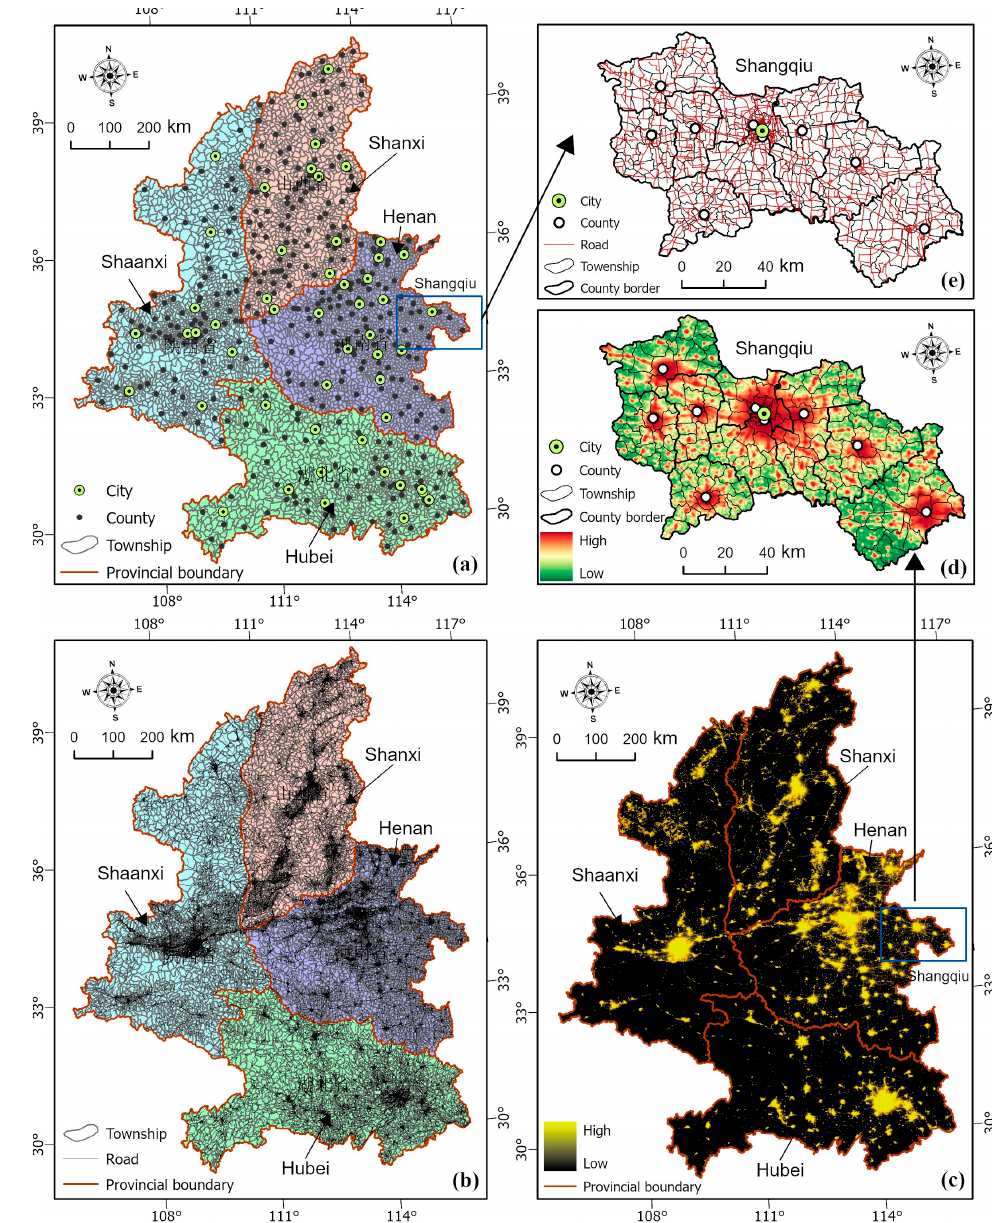
Figure 1. Study area and nightlight remote sensing imagery: ( a ) Townships in the provinces of Shanxi, Shaanxi, Henan, and Hubei in China; ( b ) Road transport network distribution in 2021; ( c ) Average nighttime light distribution in 2021; ( d ) Enlarged nighttime light view of a typical small plot; ( e ) Enlarged view of townships and roads in a typical small plot.